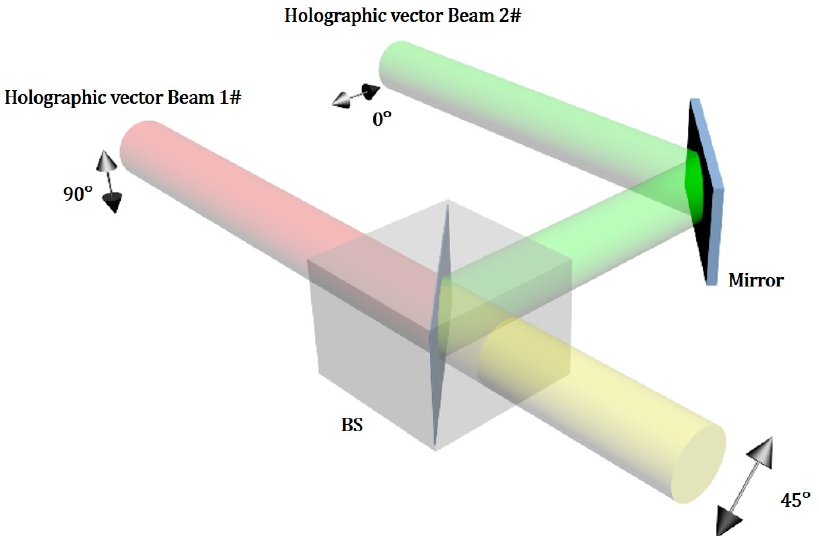
Figure 9. Schematic of the proposed method using spatial superposition of two holographic beams with orthogonal polarization states. The output of combining beams will have a 45° polarization angle when the amplitude ratio of two input beams is 1:1.